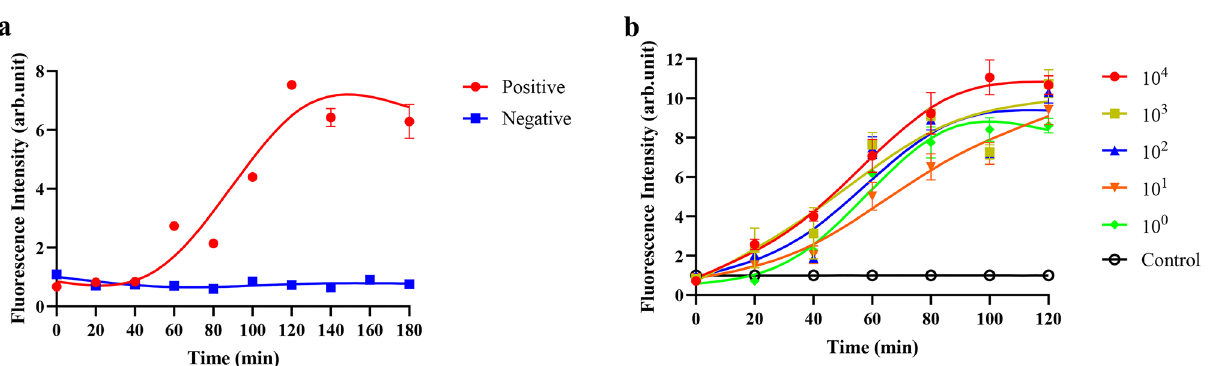
Figure 4. G4-ThT-NASBA real-time system detect CSFV-E2 RNA. ( a ) Fluorescence curve of CSFV-E2 RNA detected by real-time G4-ThT-NASBA system. Draw a curve according to the fluorescence value of the product at different reaction times. NASBA primer R2 and primer F GG29 with CSFV-E2 RNA are shown in red (positive control); NASBA primer R2 and primer F GG29 with no template are shown in blue (negative control). ( b ) Detection sensitivity of G4-ThT-NASBA real-time system. Different copies of CSFV-E2 RNA are represented by different colored fluorescence